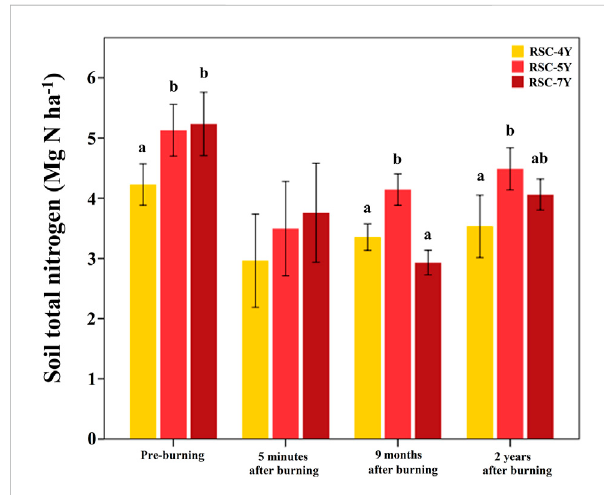
FIGURE 3 Soil total nitrogen (Mg N ha − 1 ) in the topsoil (0 – 10 cm) before burning and at 5 min, 9 months, and 2 years after burning in three fallow fi